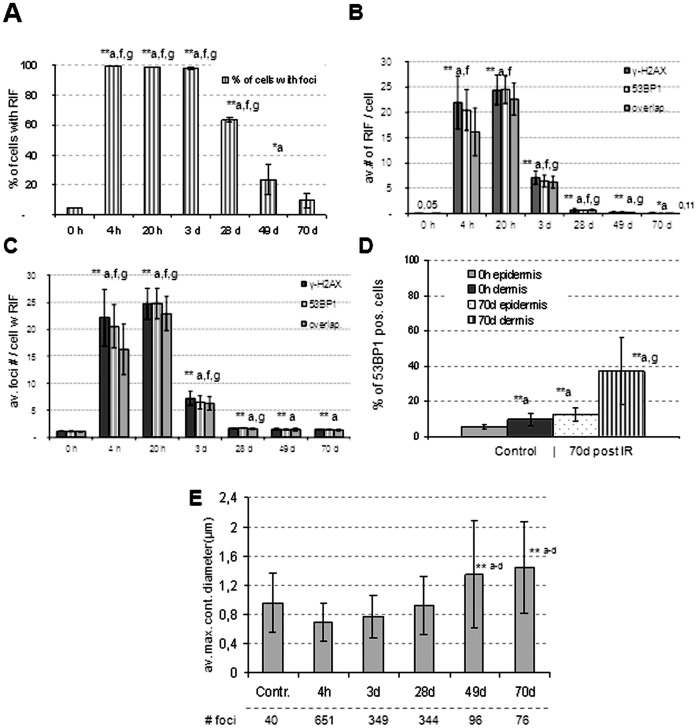
DNA damage response in epidermis sections of 140 µm unit length after in vivo exposure to 50 Gy γ-irradiation studied by radiation-induced focus analysis.The mean and SD of 3 pigs are presented, except for the 20 h and 3 day values (2 pigs). (A) 4 h and 20 h post IR all cells contained RIF. This percentage dropped after 3days post IR. (B) Average number of γ-H2AX and 53BP1 RIF per cell in skin biopsies at the consecutive time points investigated. At 4 h post IR the focus number was derived from cells with distinct γ-H2AX labeling (see text, Fig.1A). “Overlap” addresses foci with γ-H2AX and 53BP1 signal colocalization, which is complete at late time points. (C) Average foci numbers in keratinocytes that carry ≥1 RIF are significantly increased relative to control, 4 h and 20 h time points (**p<0.001). (D) Percentage of cells carrying ≥1 53BP1 RIF at 70 days post IR. There is a significant difference (**, p<0.001) between keratinocytes of the hair sheath (70d dermis) and all other conditions. (E) At ≥49 days post IR the mean 53BP1 foci diameter (maximum contour radius ± SD) is significantly increased (**, p<0.002). Error bars reflect differences of 3 different animals. Significant differences were noted a relative to control, b relative to 4 h, c to 3 days, e to 28 days, f to 49 days and, g relative to 70 days.